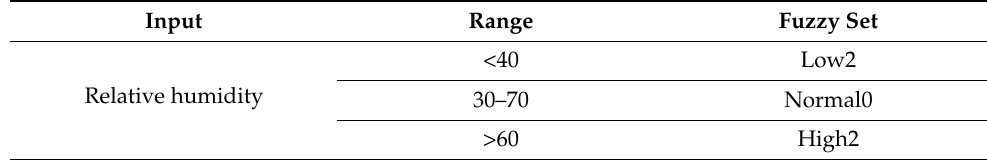
Table 6. Ranges of relative humidity and their respective fuzzy